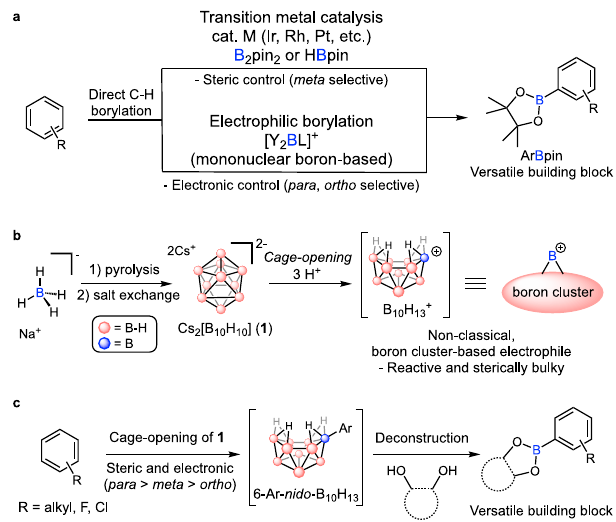
Fig. 1 | Borylation of aromatic C – H bonds. a Conventional routes to aryl boronic esters by direct arene borylation. b Cage opening of [B 10 H 10 ] 2 – to generate a non- classical boron cluster-based electrophile. c Synthetic approach through cage opening of [B 10 H 10 ] 2 – followed by the deconstruction of the corresponding 6-Ar- nido -B 10 H 13